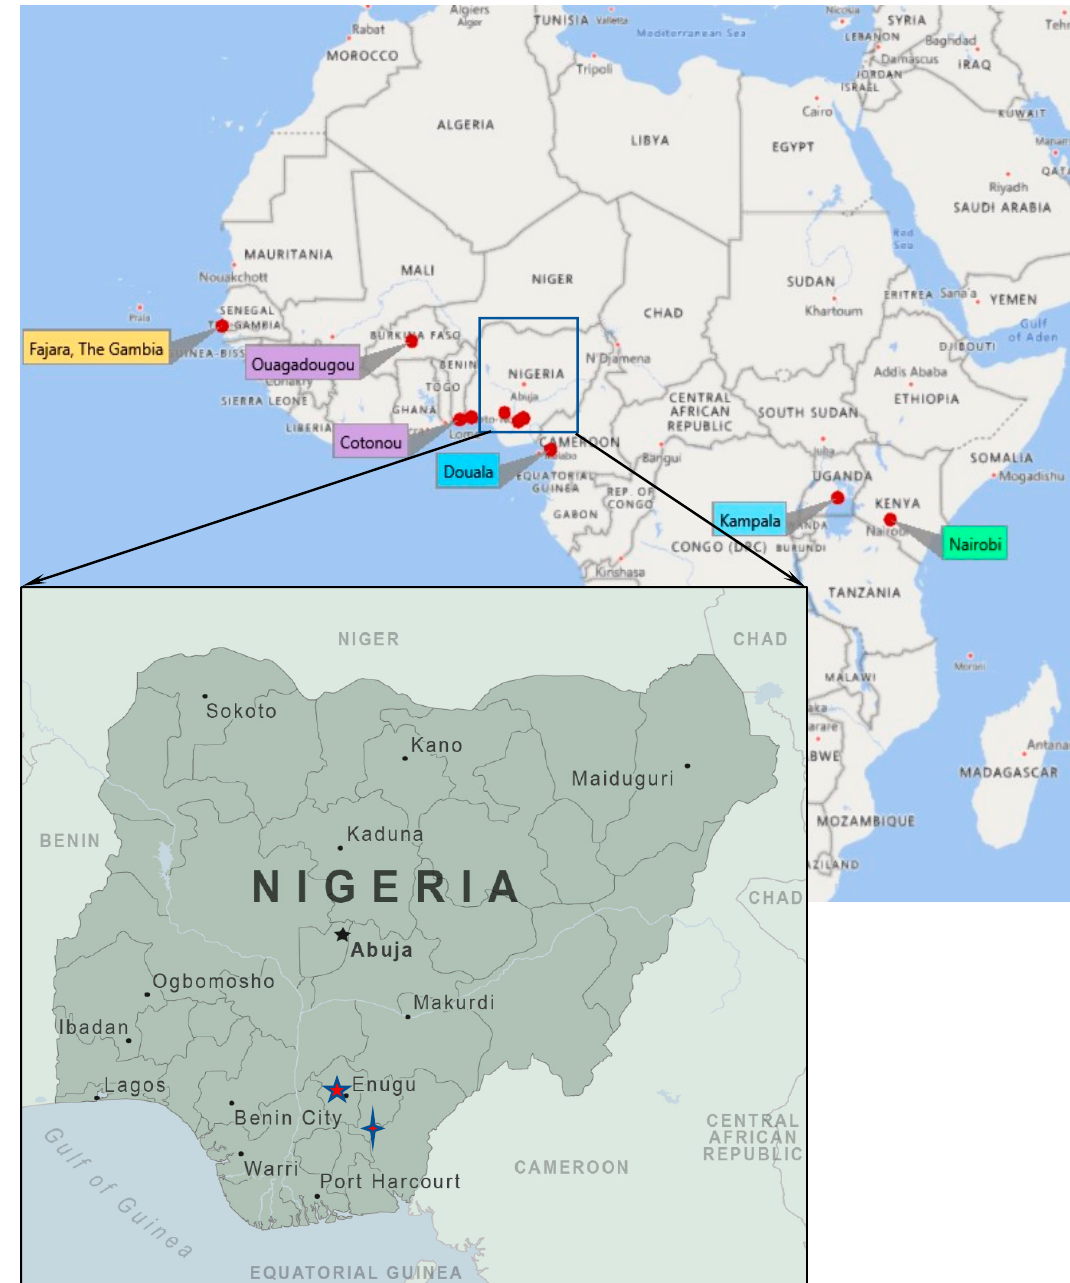
Figure 1. Map of sub-Saharan Africa showing the 13 study sites (including 4 in Enugu, and 2 in Anambra, both in Nigeria) across 7 countries. —Four sites in Enugu, Nigeria, —Two sites